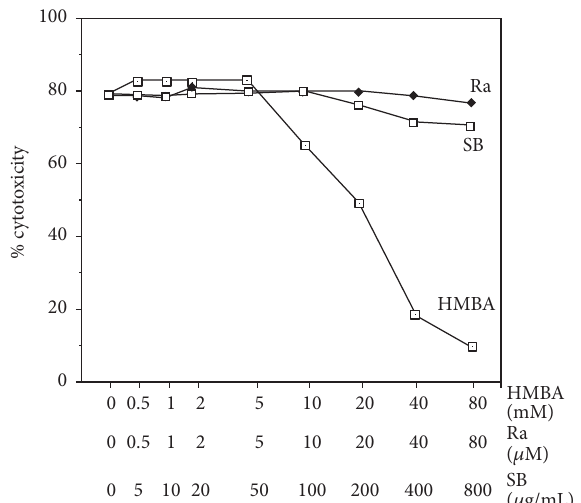
Figure 8: Effect of cytodifferentiation agents on cytotoxicity of TNF- 𝛼 secreted by LPS-pulsed AMC. After 1 h of 0.02 𝜇 g/mL LPS stimulation, AMC were washed and further incubated overnight in the presence of cytodifferentiation agents at various concentrations (as summarized in Table 1). TNF cytotoxicity in 5x diluted supernatants was